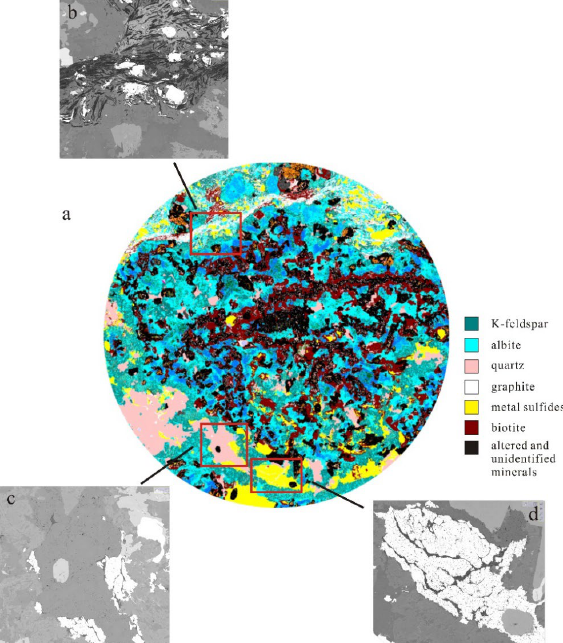
Figure 5. ( a ) Scan results of QEMSCAN and MAPS test; ( b ) the flake graphite was mainly distributed as bundled and banded aggregates, cutting through and metasomatizing sulfides; ( c ) the quartz, mainly occurring as xenomorphic granular metasomatized sulfides and contained a small amount of fine-grained disseminated graphite; ( d ) the sulfide aggregates cut and metasomatized by quartz contained fine-grained graphite bands.